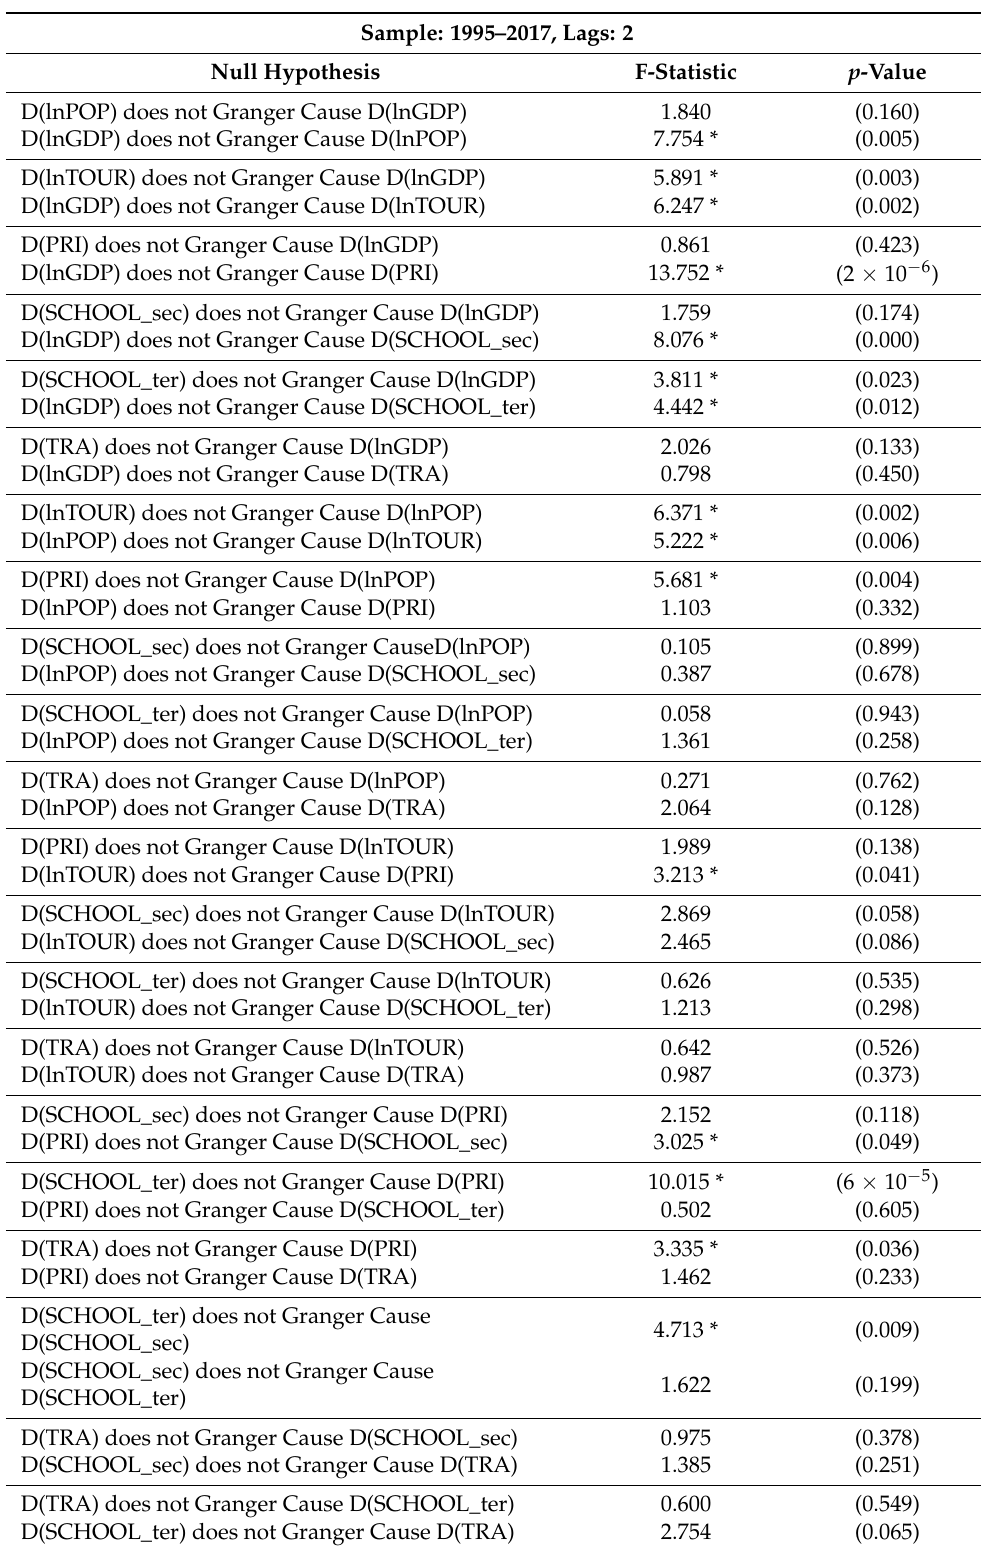
Table 5. Pairwise Granger causality